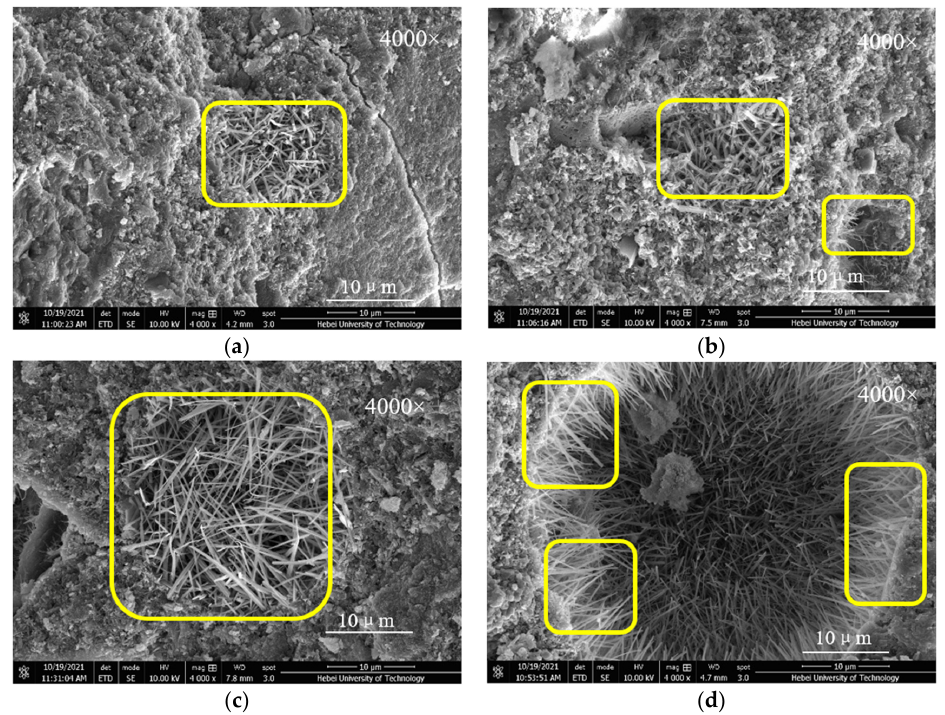
Figure 10. SEM images of MOSC with different mineral admixtures after 28 days of curing: ( a ) C; ( b ) C-10FA; ( c ) C-10MK; ( d ) C-(5MK+5FA). Remark: Phase 517 is shown in the yellow frame.